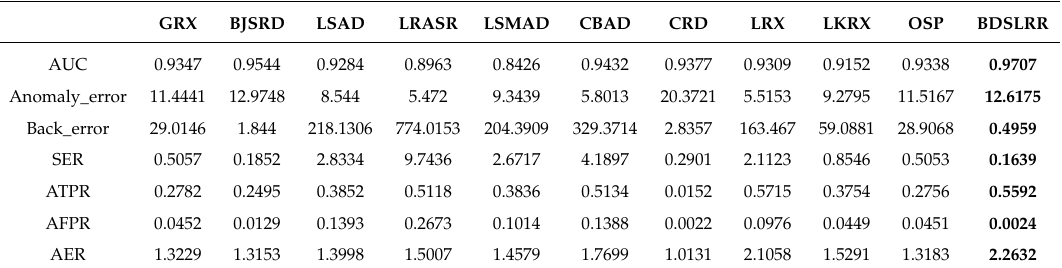
Table 3. Urban Dataset: Assessment Metric Summary.